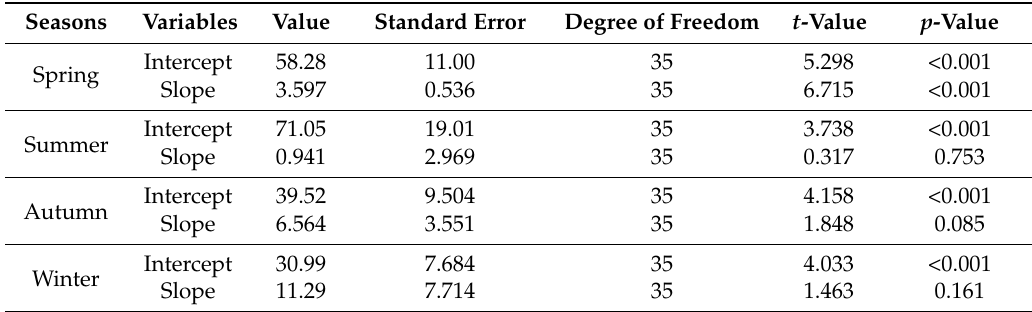
Table 4. Linear Mixed Effects Model analyses for the relationship between phytoplankton biomass and copepod abundance in different seasons.